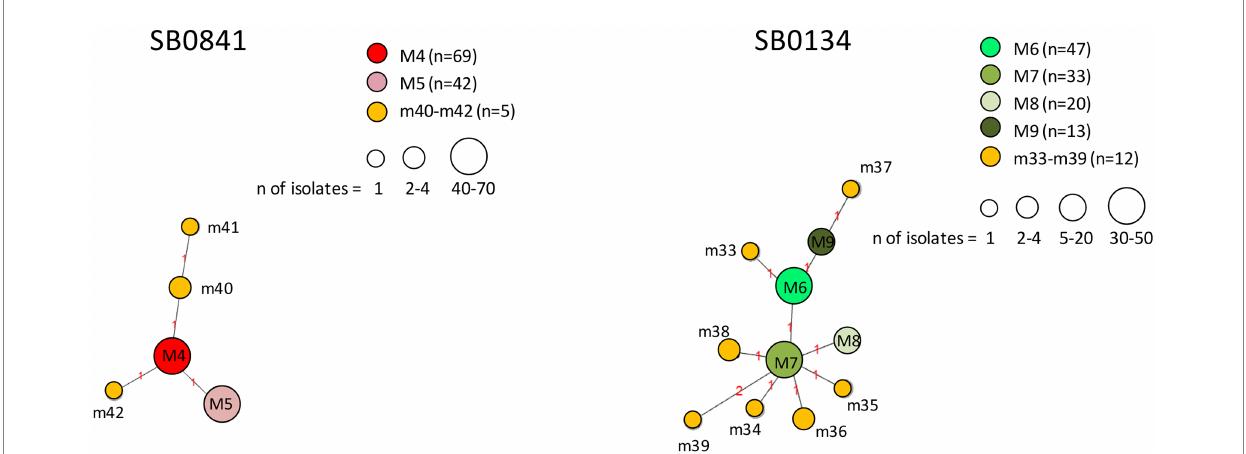
FIGURE 10 Minimum spanning trees of Mycobacterium bovis isolates belonging to spoligotypes SB0841 and SB0134. The number of isolates ( n ) is indicated in the legend, in parentheses. Each circle represents a distinct 12-locus MIRU-VNTR code. The color of the circle represents a profile, as indicated in the legend: each of the major profiles has been assigned a distinct color (red or a shade of green), whereas all minor profiles are shown in orange. The size of the circles is proportional to the number of isolates. Branch lengths correspond to the number of locus differences. Link labels refer to the distance matrix. The tree is based on PHYLOViZ